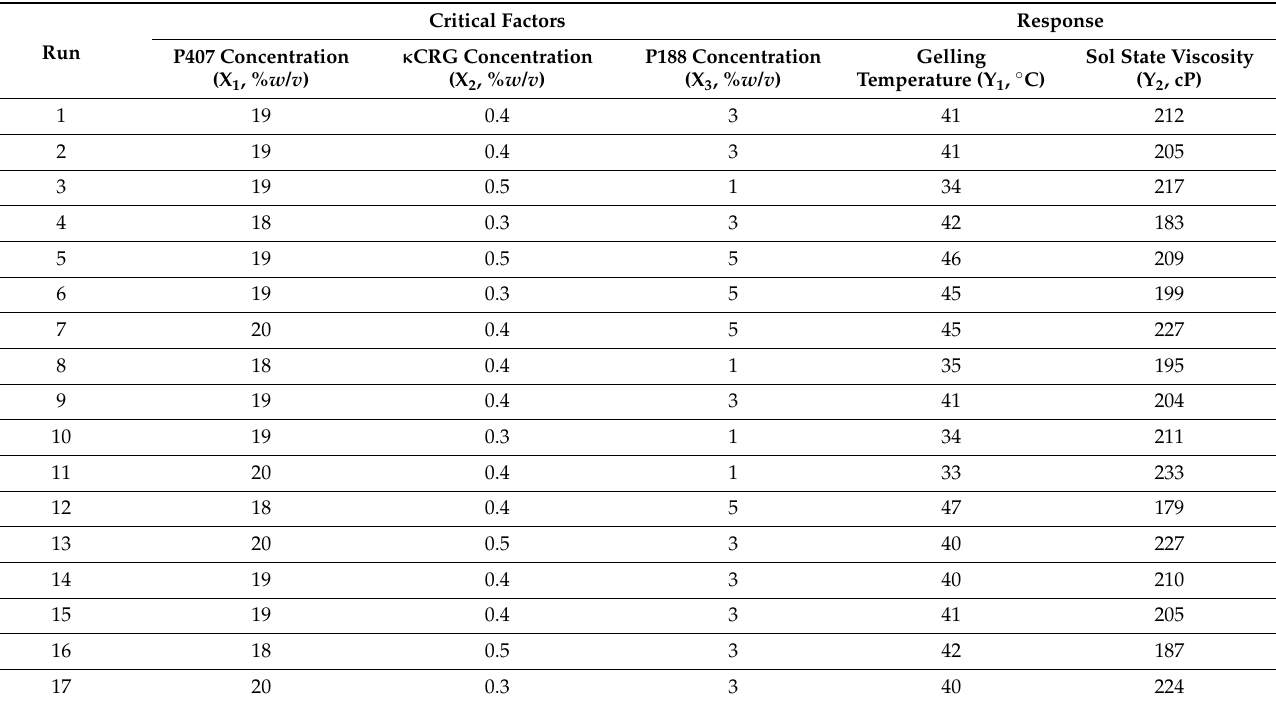
Table 2. Design matrix of the 17 experimental runs generated by BBD and responses obtained from characterization of NEB-loaded dual-responsive in situ gels in terms of gelling temperature and solution state